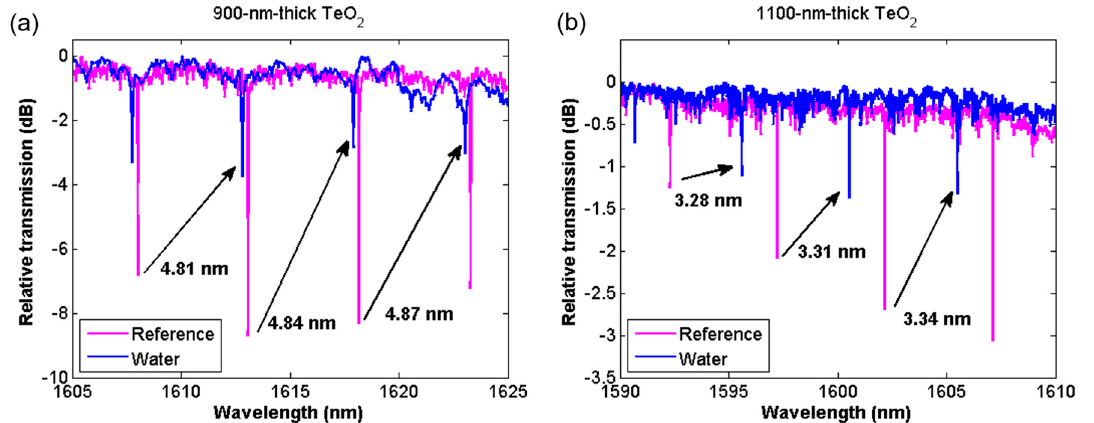
Figure 5. Resonance spectra measured in air (pink) and after covering the chip in water (blue) for ( a ) 900-nm-thick and ( b ) 1100-nm-thick TeO 2 resonators.